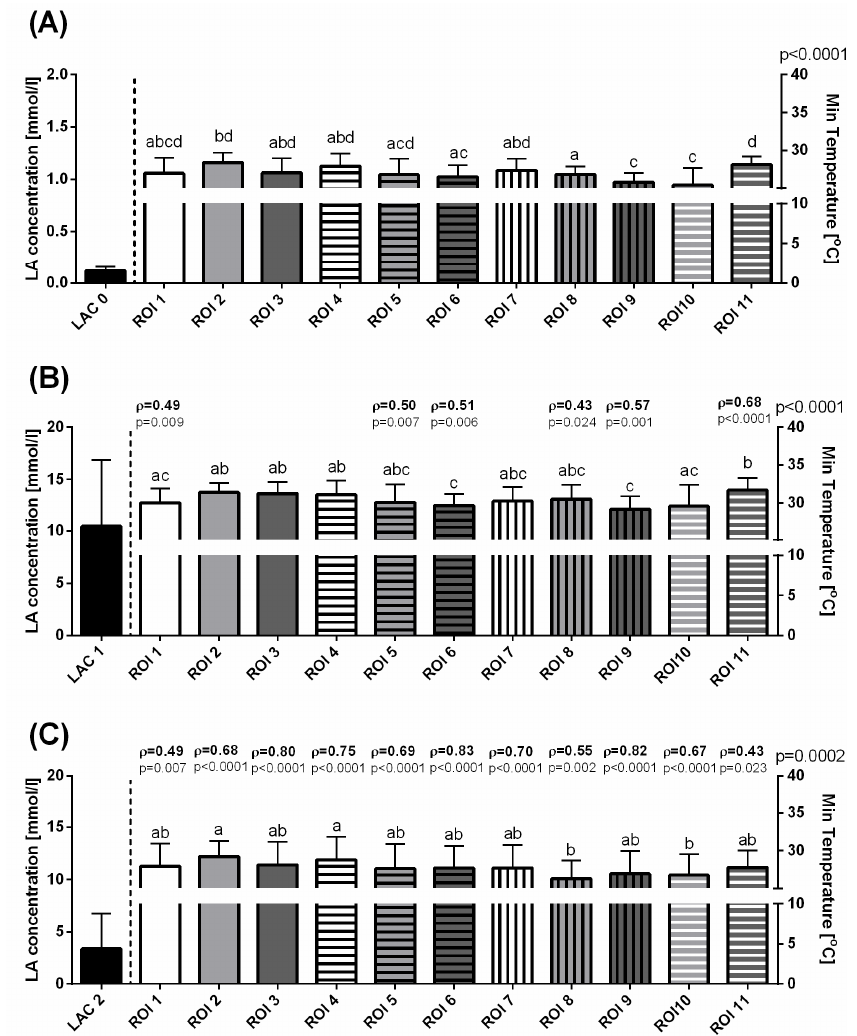
Figure 4. The blood lactate concentration and minimal temperatures (mean + SD) in the selected ROIs before training ( A ), immediately after exercise ( B ), and 30 min after exercise ( C ). Lowercase letters indicate di ff erences between regions of interest (ROIs) for p < 0.05. The p -value for ROI comparison is indicated above the right X -axis. The correlations between blood lactate concentration and minimum temperatures are indicated above consecutive temperature bars using the Spearman correlation coe ffi cient ( ρ ), which reflected the consistency when p < 0.05.